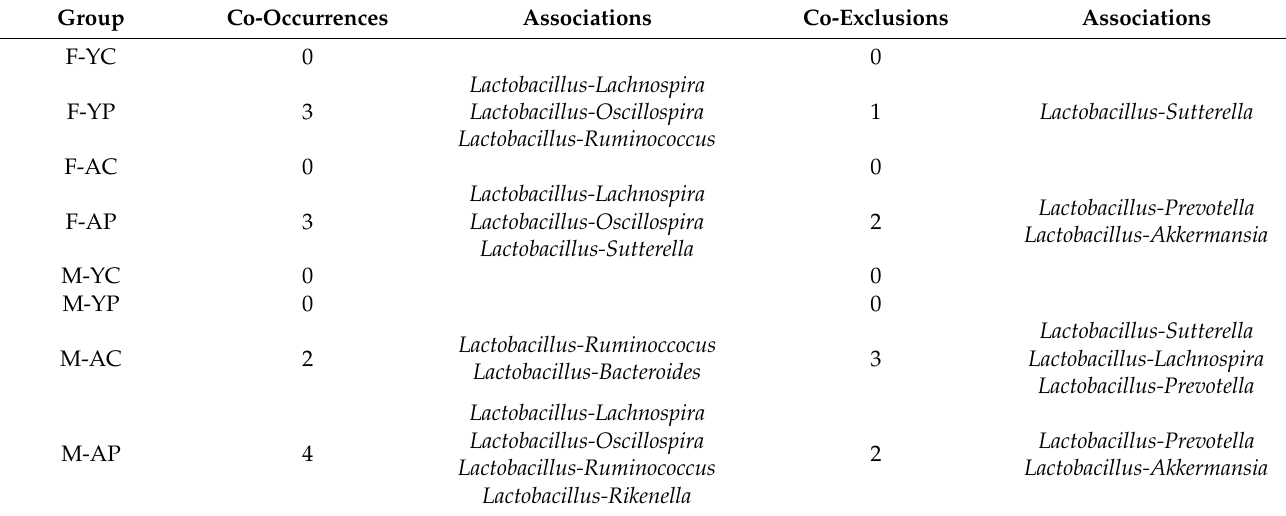
Figure 5. Microbial co-occurrence in the fecal microbiome in young and aging mice at the phylum level. Co-occurrence networks were constructed based on relative abundance profiles using Kendall’s Tau correlation analysis in young control ( A ), young probiotic ( B ), aging control ( C ), and aging probiotic ( D ) groups. Each node represents a phylum. Each edge indicates the sign of the association (green = positive (co-occurrences), red = negative (co-exclusions)). The thickness of the nodes represents the level of association between taxa. Table 1. Summary of number of associations based on the Lactobacillus genus in all four groups across the sample